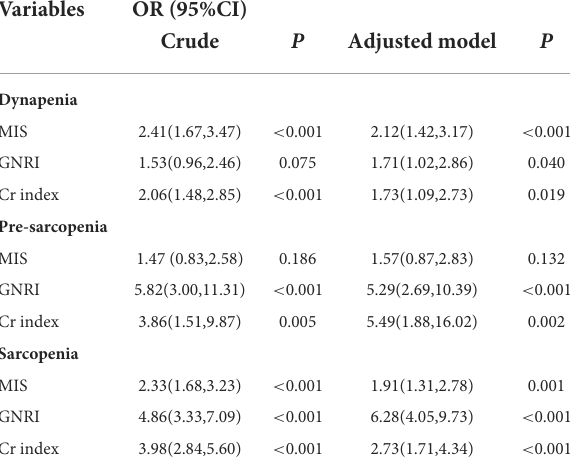
TABLE 3 Multivariable logistic regression analysis evaluating nutritional factors associated with dynapenia, pre-sarcopenia, and sarcopenia.